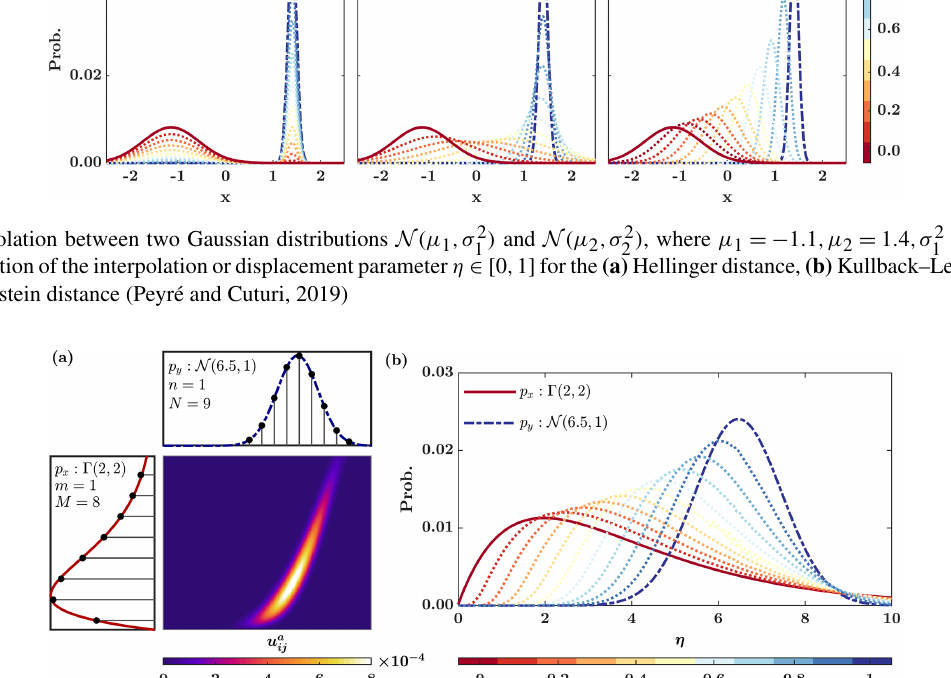
Figure 2. (a) Optimal transportation plan or the joint distribution U a between a gamma (cid:48)( 2 , 2 ) and a Gaussian marginal distribution N ( 6 . 5 , 1 ) and (b) the 2-Wasserstein interpolation between them for different values of the displacement parameter η ∈ [ 0 , 1 ]